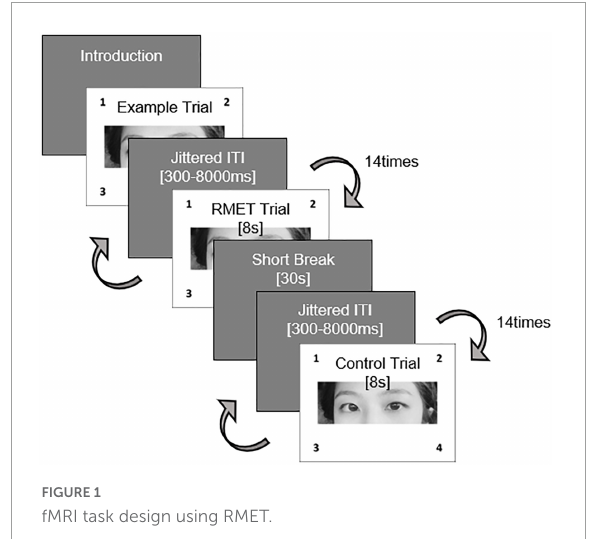
FIGURE1 fMRI task design using